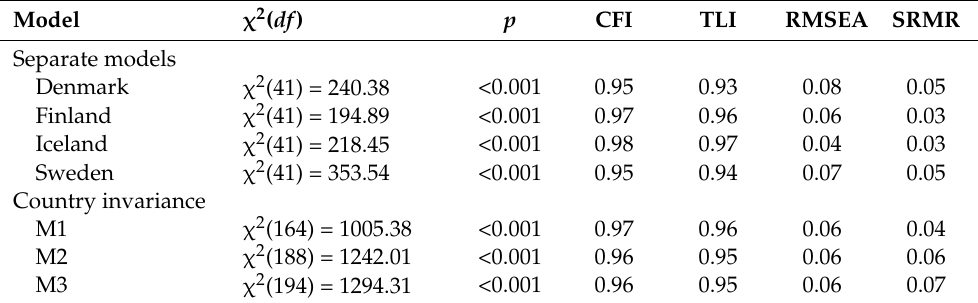
Table 4. Model fit indices for Denmark, Finland, Iceland, and Sweden and multi-group invariance across Nordic